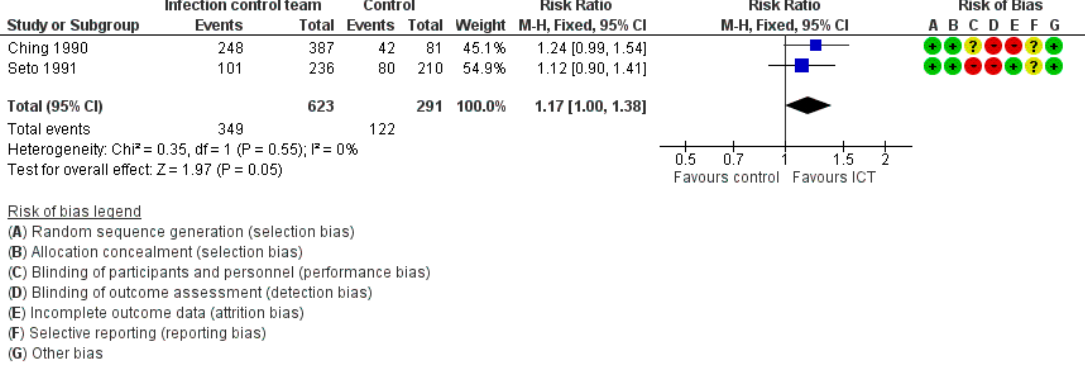
Figure 6. Meta-analysis for the proportion of compliance with infection control practices [26,33].